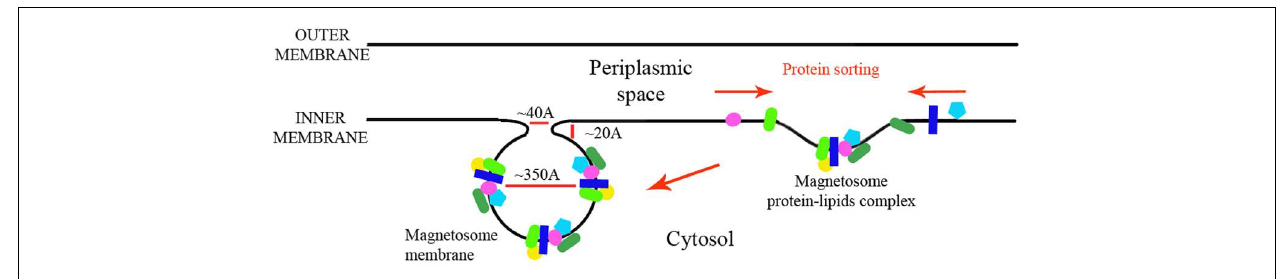
FIGURE 8 | Magnetosome membrane invagination